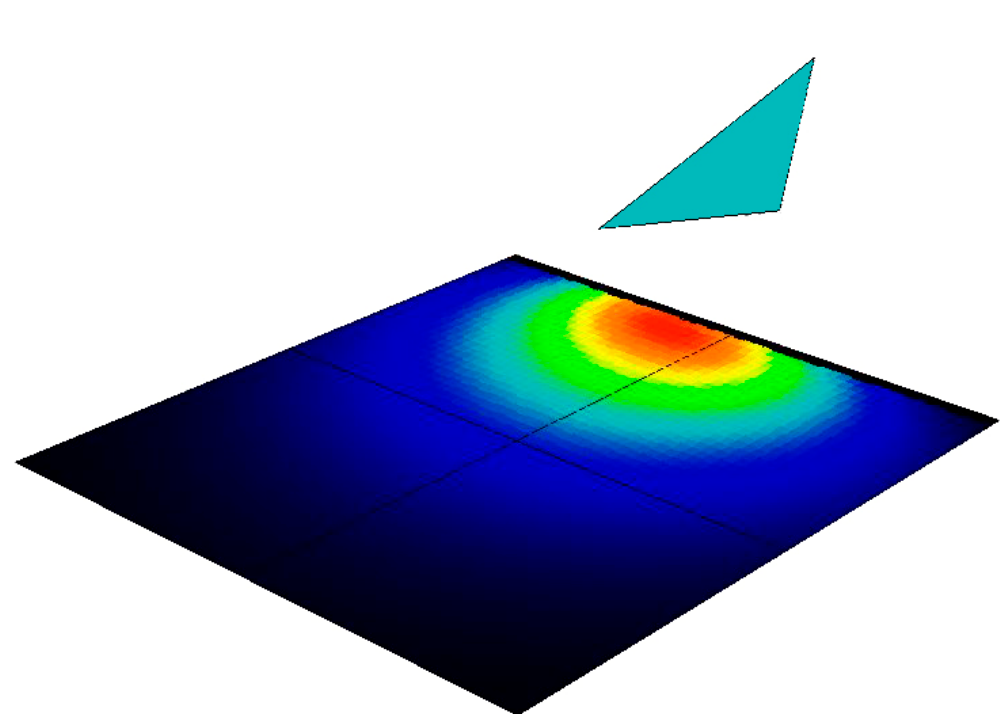
Figure 17. Sketch of the dimensions of a vertical scalene triangle radiating over a horizontal area of 10 × 10 m 2 .